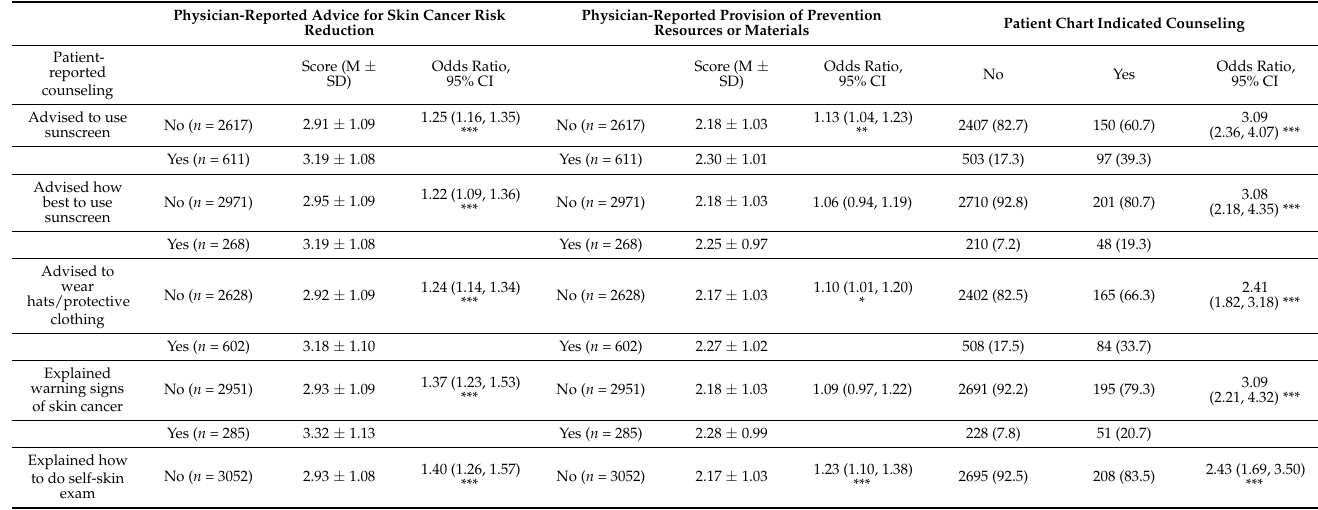
Table 2. Logit analysis comparing patient-reported, primary care physician-reported, and patient chart documentation of skin cancer prevention